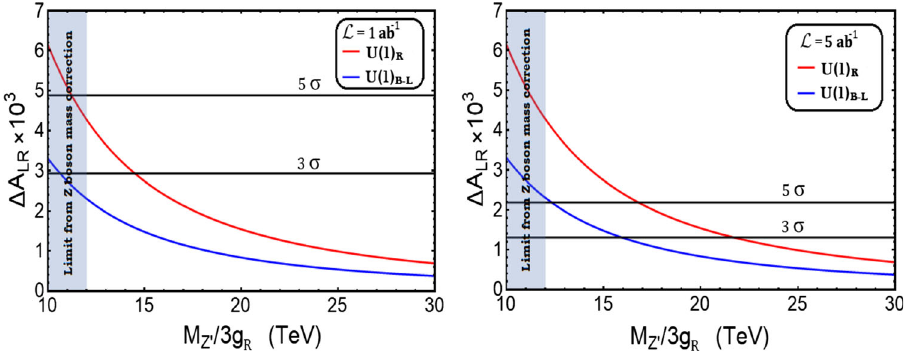
√ s = 500 GeV with 1 ab − 1 (left) and 5 ab − 1 (right) inte- of the ILC at grated luminosity. Here the horizontal lines corresponding to sensitivity confidence level 3 σ and 5 σ , and the grey shaded region corresponds to excluded region from the Z boson mass correction